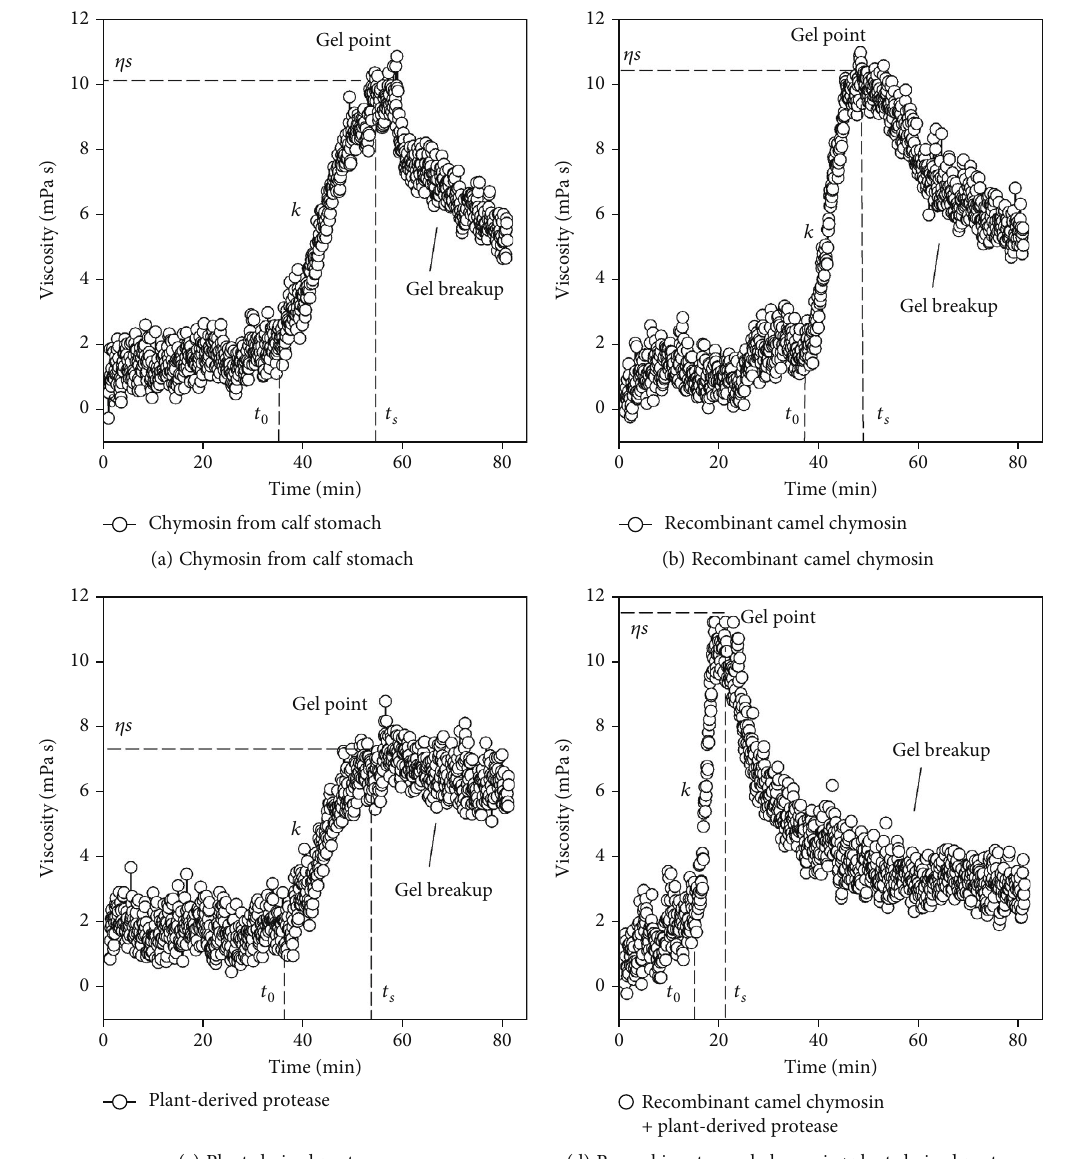
k =rate of caseins aggregation, s =viscosity at gel point,